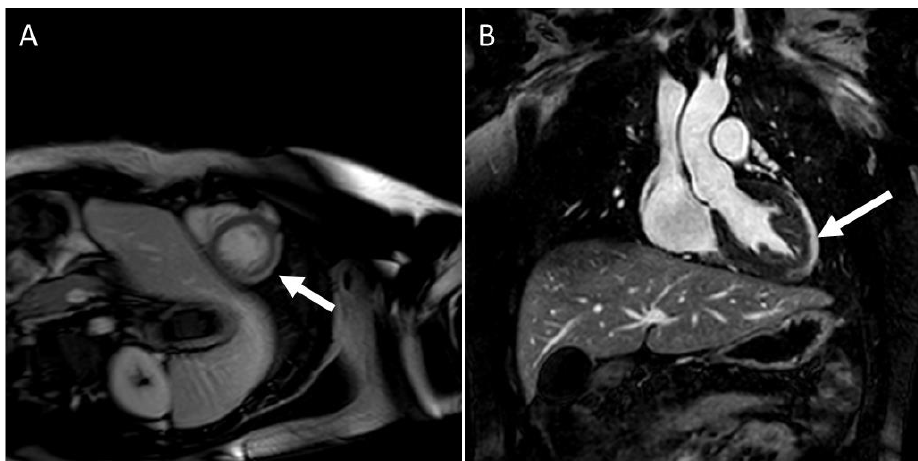
Figure 4. CMR in an adolescent with acute myocarditis: ( A ) Shows subepicardial early gadolinium enhancement (EGE) (white arrow); ( B ) Shows subepicardial LGE (white arrow). Patients with DCM often have a linear mid-myocardial LGE pattern, but a subendo- cardial pattern strongly suggests previous myocardial ischemia or necrosis due to micro- thrombus but spontaneous coronary recanalization or distal embolization from minimally stenotic coronary lesions [33]. In contrast, chronic myocarditis rarely presents with a sub- endocardial LGE pattern and rarely follows coronary artery distribution. Instead, the hall- mark LGE pattern of chronic myocarditis consists of patchy or longitudinal striae of mid- wall and subepicardial enhancement. In chronic myocarditis, parametric tissue mapping to evaluate myocardial T1 relaxation time and ECV helps detect diffuse fibrosis without focal LGE [34]. Table 1. CMR findings in clinically suspected acute and chronic myocarditis in children.